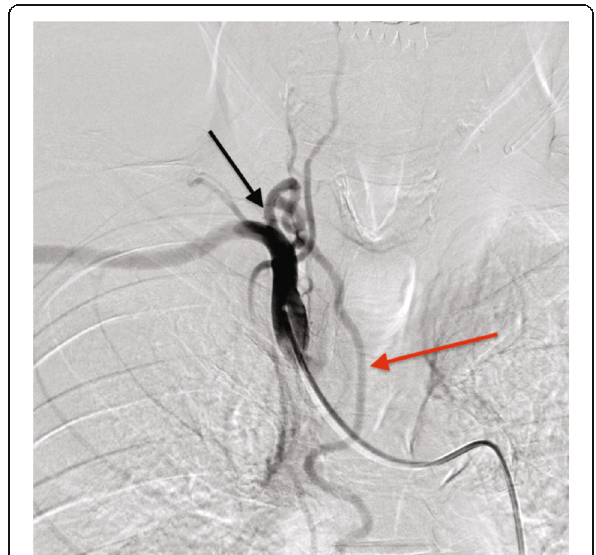
Fig. 3 Angiogram of the brachiocephalic artery shows the hypertrophic ectopic bronchial artery (red arrow) arising from the right thyrocervical trunk (black arrow), findings that corresponded with the CTA image